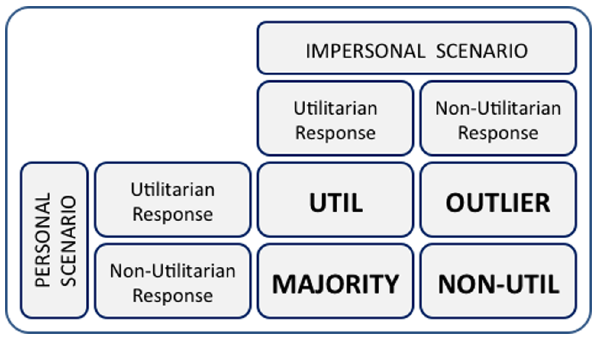
Figure 1. Grouping criteria based on responses to impersonal and personal moral